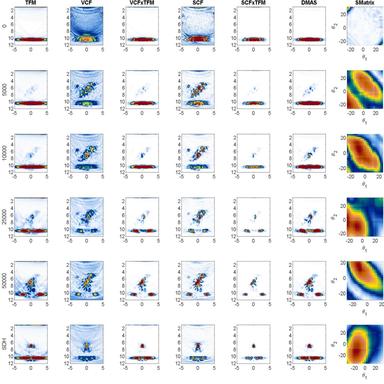
TFM, VCF, VCFxTFM, SCF, SCFxTFM, DMAS and scattering matrices for simulations without noise.